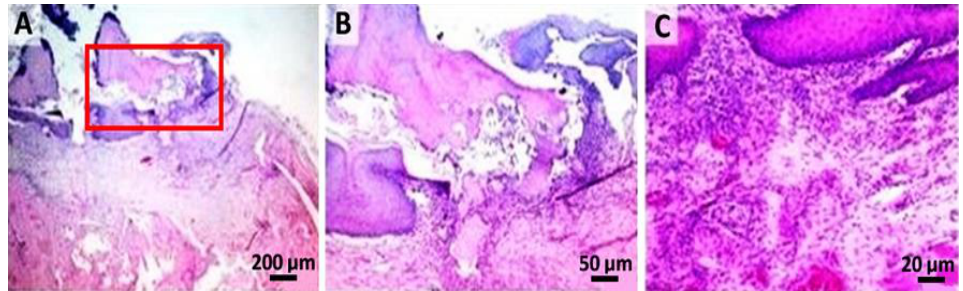
Figure 6. Laser group: ( A ) hyperplasia and marked hyperkeratosis of the gingival epithelium (hematoxylin – eosin); ( B ) high resolution, 50µm, of the marked zone with red from image A; ( C ) numerous neutrophils with rare mononuclear and reactive fibroblasts.